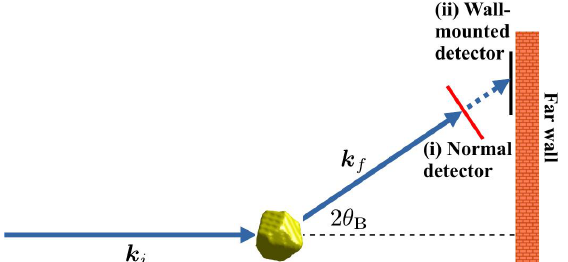
Figure 1. Schematic of a BCDI diffraction geometry with different detector configurations: (i) the traditional mounting normal to the exit beam, which is arranged by diffractometer rotation stages and a radial arm, and (ii) an unconventional wall-aligned mounting (i.e., normal to the incident beam). The latter is easily achieved with inexpensive translation stages that move the detector parallel to the far-wall of the experimental